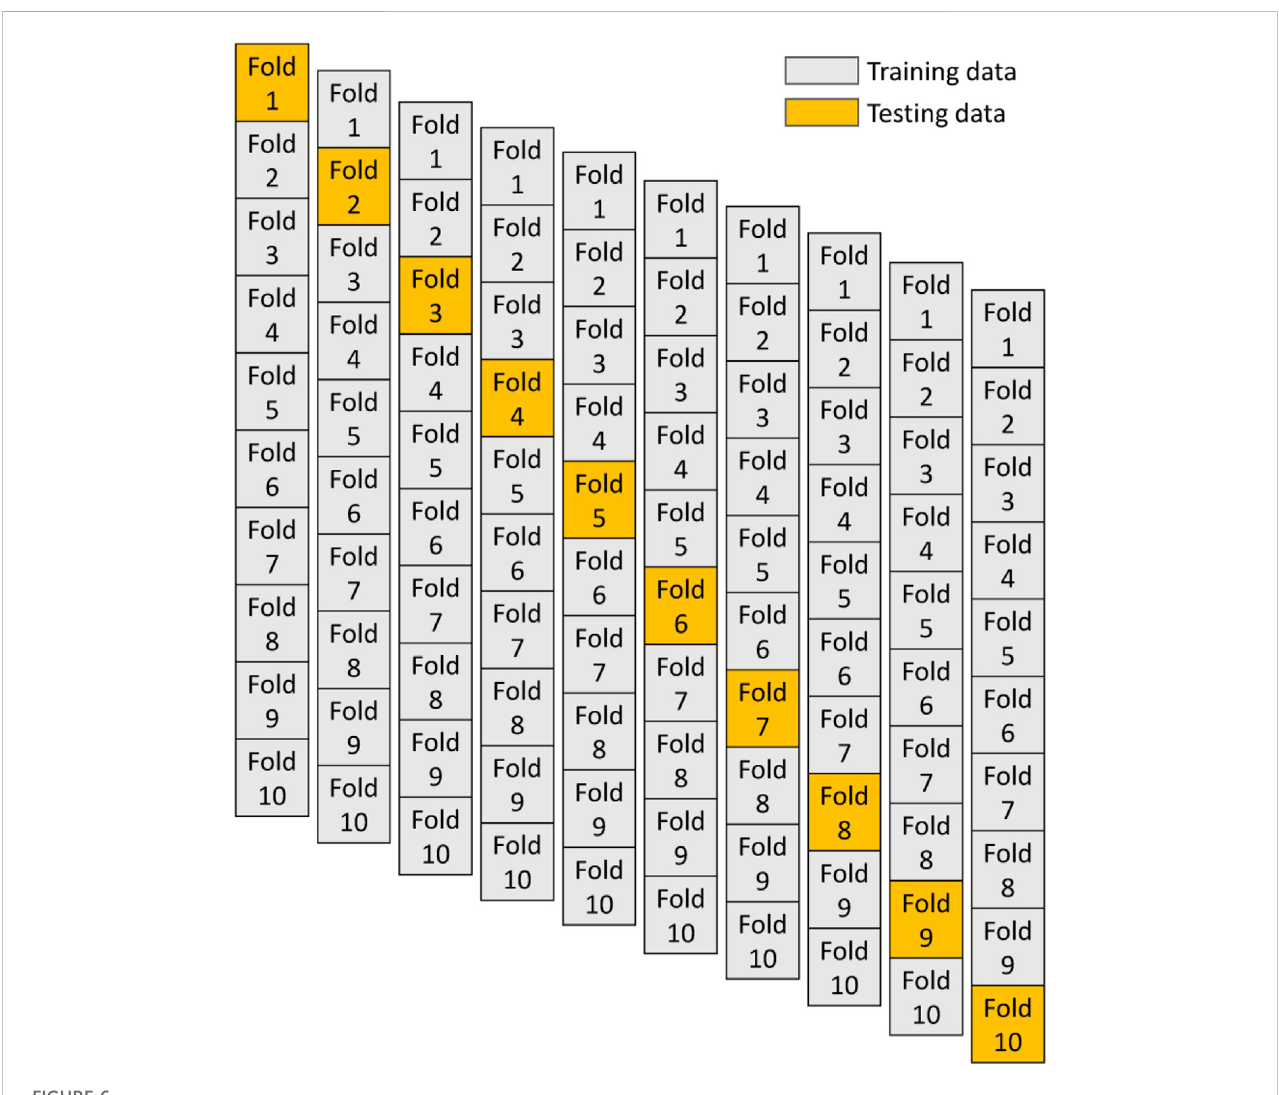
FIGURE 6 K-fold cross-validation approach (Zou et al.,